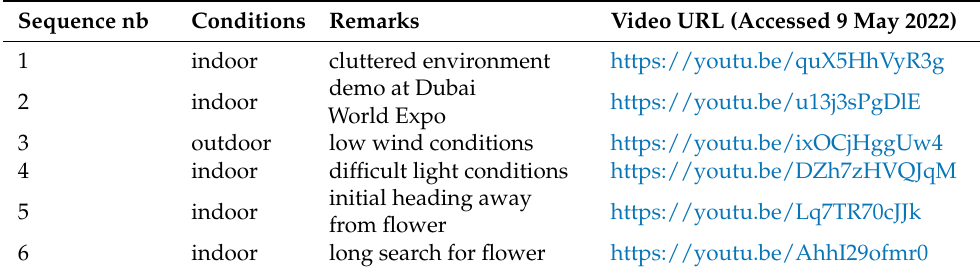
Table 2. Demonstrations of the full navigation